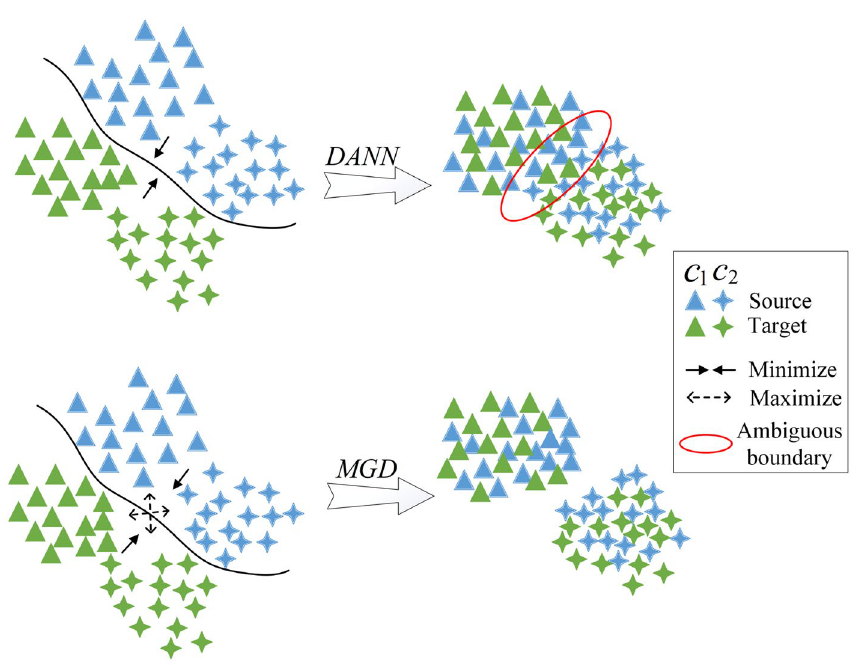
Figure 2. A comparison between the traditional domain discriminator DANN and the proposed MGD, where minimization means that the distribution difference is minimized in different domains and maximization means that the distribution difference is maximized between different classes, which come from different